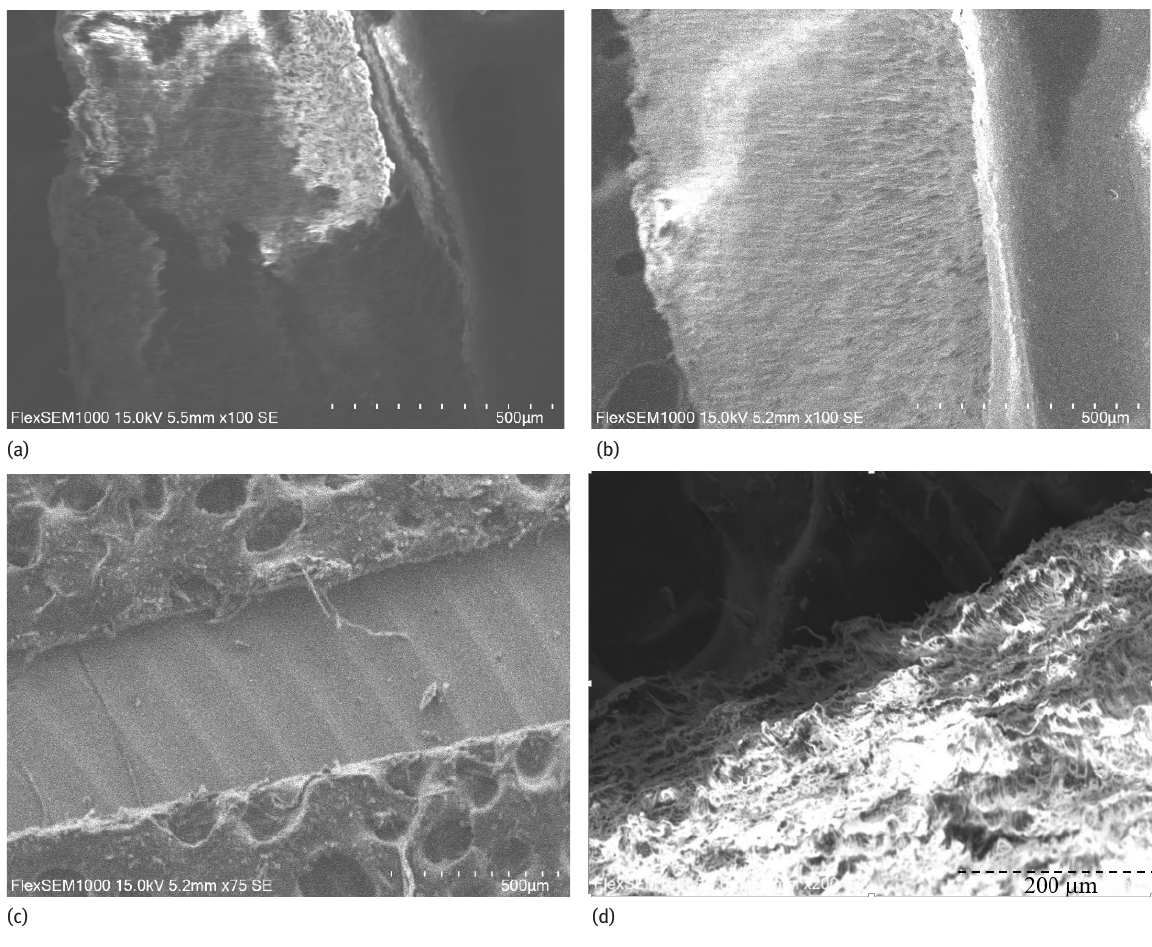
Figure 6: SEM micrographs of PVC0 (a), PVC1 (b,c) and PVC7